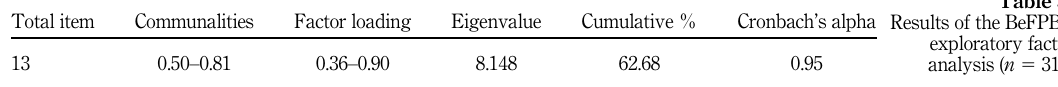
Table 3. Results of the BeFPBQ